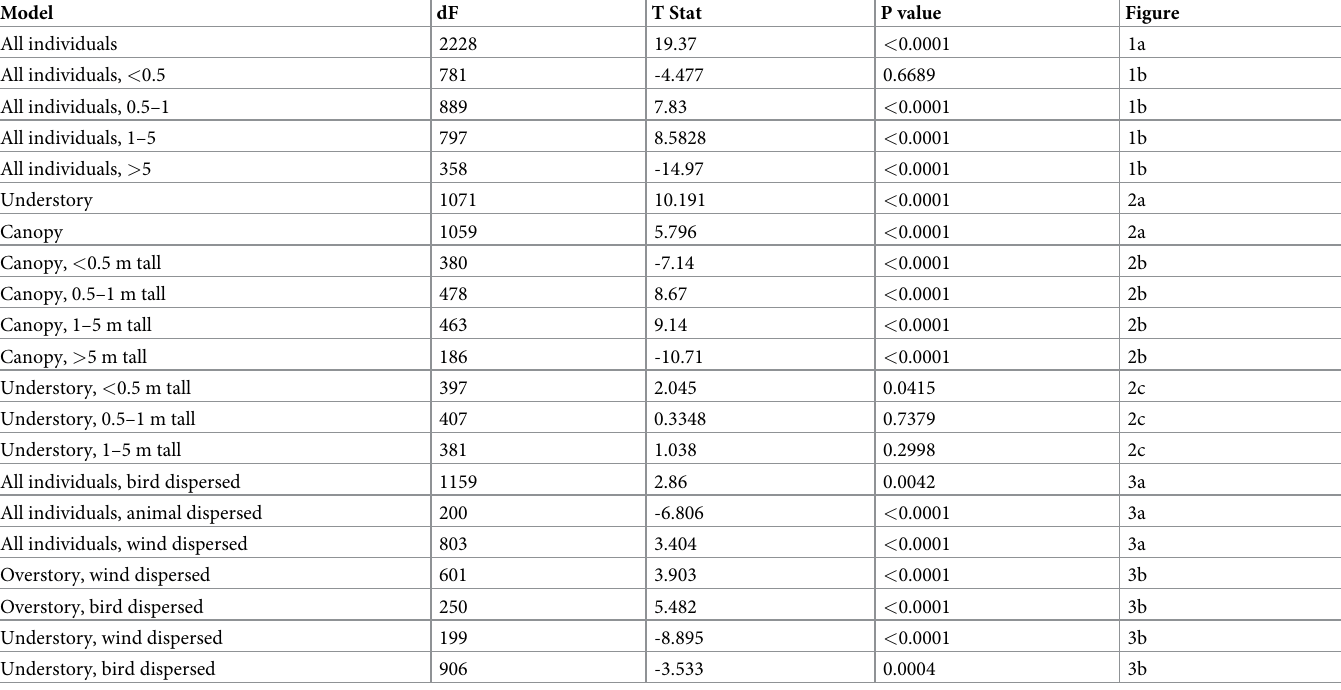
Table 1. Results of mixed effects linear model to calculate L statistic significance at Powdermill Nature Reserve in Southwestern Pennsylvania for all comparisons of all individuals > 10 cm height. Model dF T Stat P